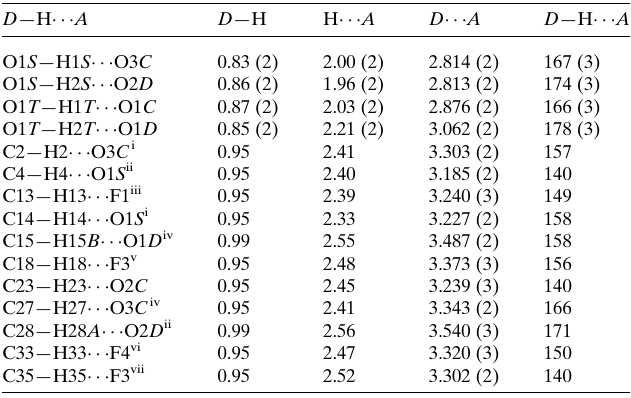
Table 1 Hydrogen-bond geometry (A˚ , (cid:3) ).